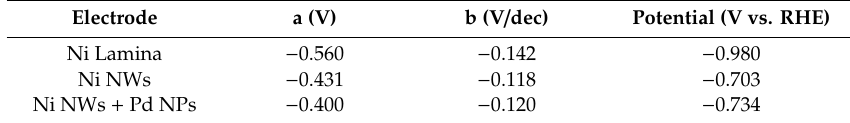
Table 2. Fitted Tafel parameters for HER and potential mean value for a mid-term galvanostatic test at